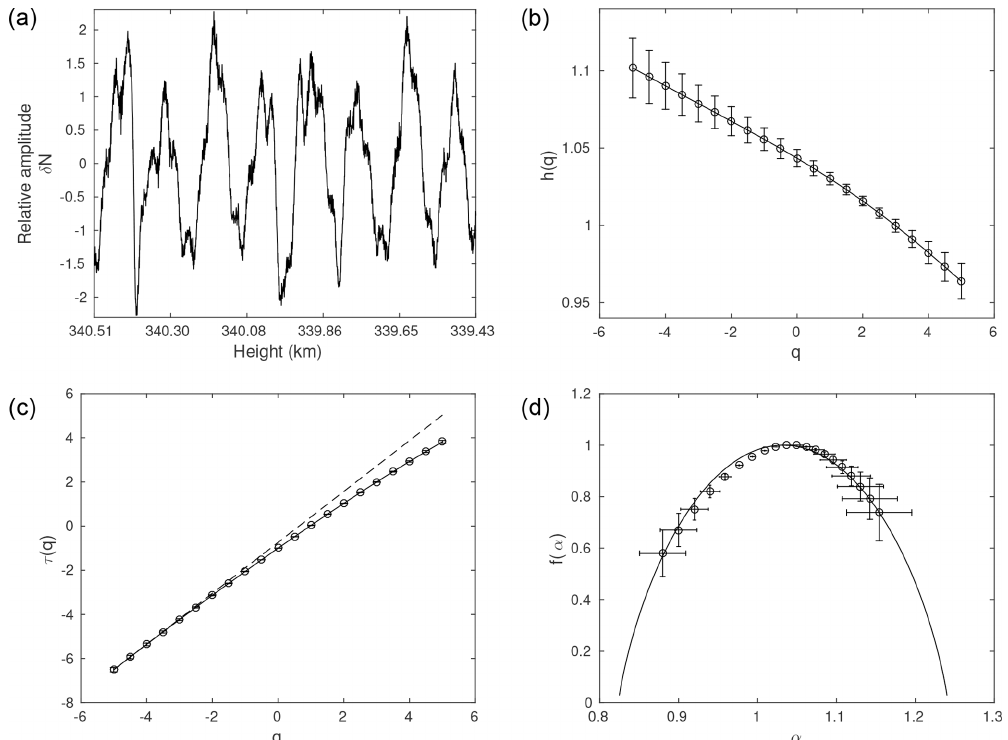
Figure 2. Comprehensive MFDFA for the second experiment: panel (a) shows the time series at mean height 339 . 94km and panel (b) shows the h(q) vs. q profile. Panel (c) shows the τ(q) vs. q profile along with a dashed line which represents a linear relationship between τ(q) and q , and panel (d) shows the multifractal spectrum fitted with the p -model (continuous line).